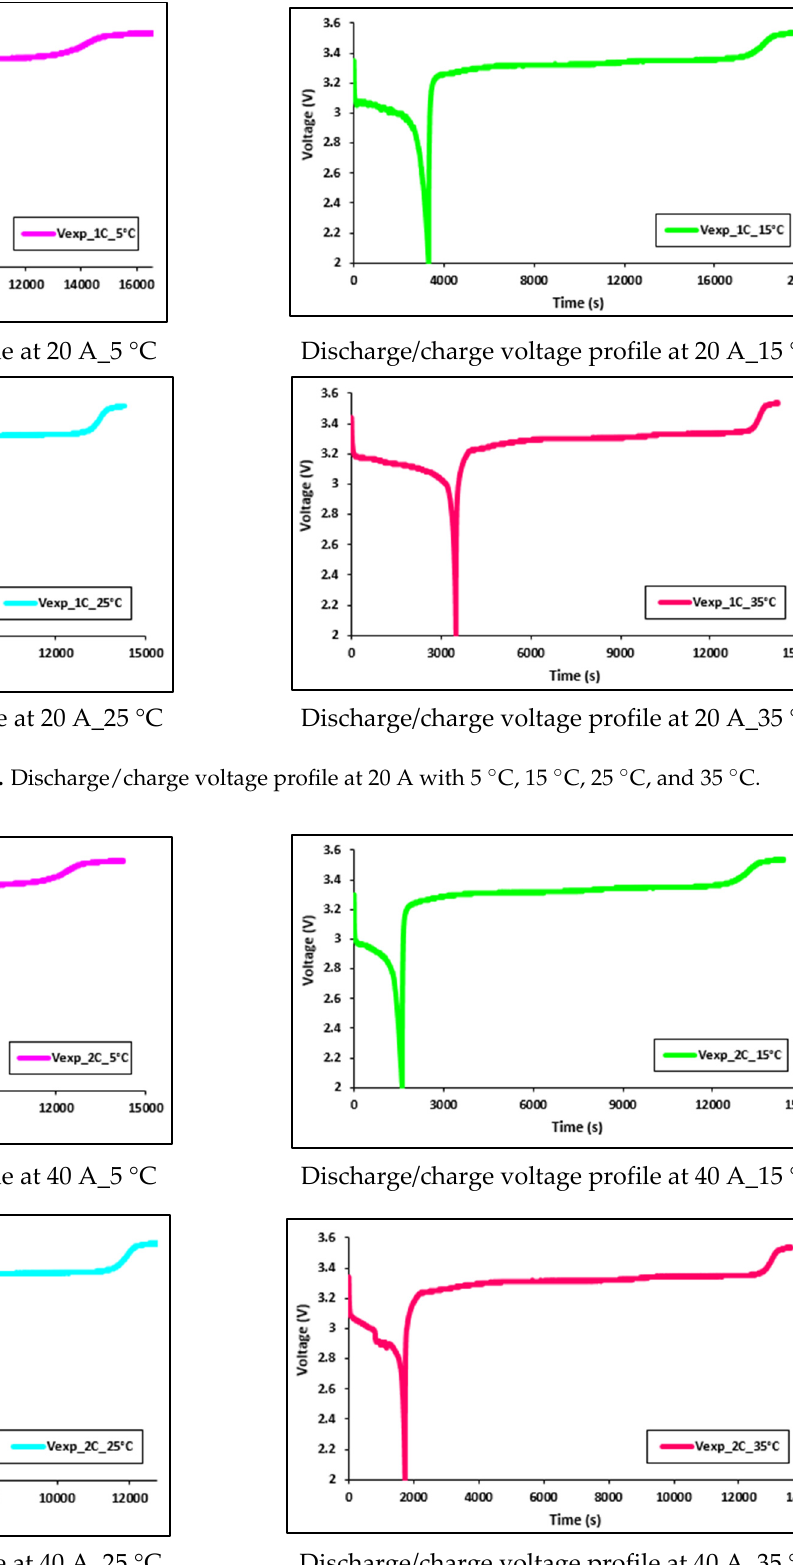
Figure 18. Transient temperature profile of water flow at 40 A with 5 °C, 15 °C, 25 °C, and 35 °C.